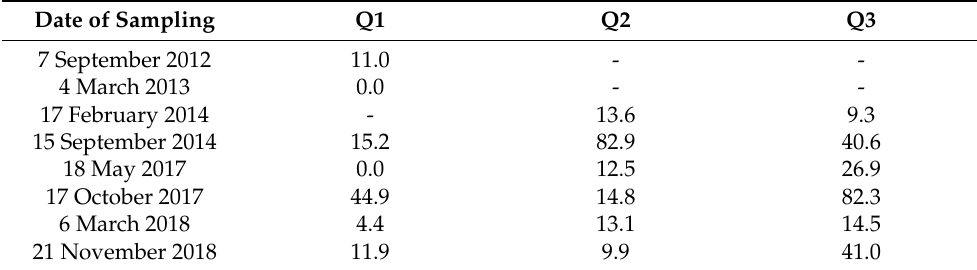
Table 6. Monthly flow (mm) at the time of sample collection for tritium analysis in the three Quivolgo